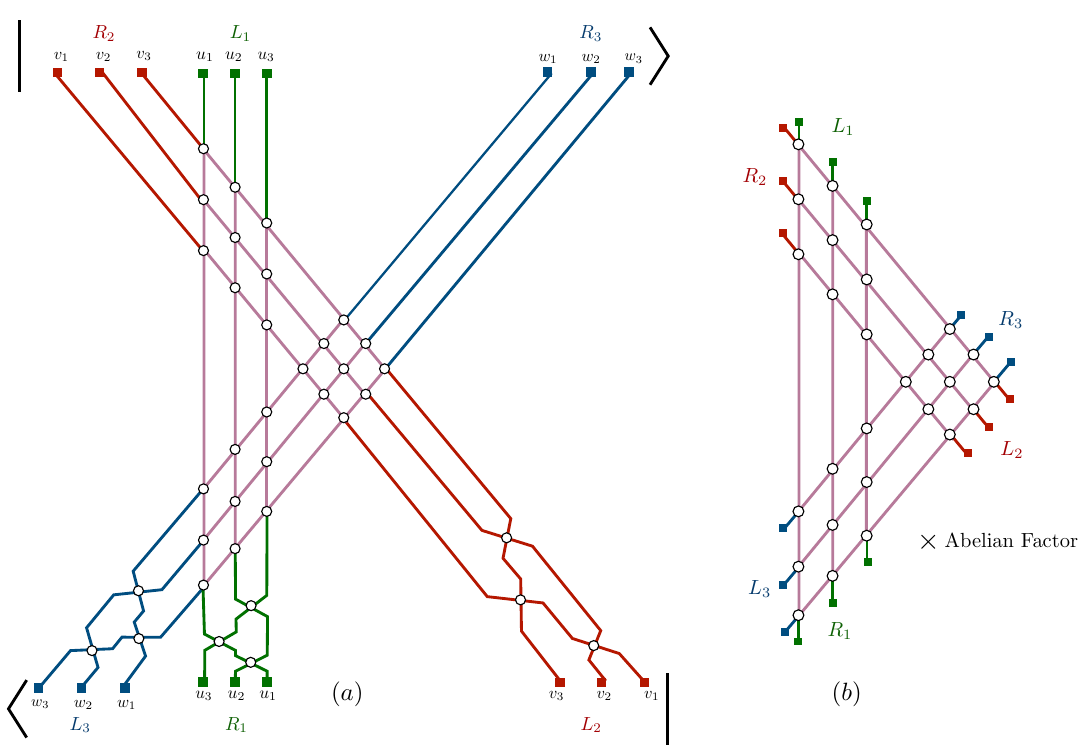
, illustrated here in the case Z , describe Figure 1 . (a) The hexagon partition function Z J 3 , 3 , 3 1 ,J 2 ,J 3 the scattering of three sets of fermions, labelled by their rapidities v , in the N = 4 i , u j , w k SYM spin-chain. Each set starts polarized in a fixed direction labeled by the spinors R 2 , L 1 , R 3 respectively. The particles then scatter in all possible pairings according to Beisert’s PSU(2 | 2) vertex. The final state is then projected into fermions of definite polarization spinors L . 2 , R 1 , L 3 In the gauge theory, the boundary conditions are set by the spacetime polarizations of spinning operators whose structure constants are governed by the hexagon partition function. Because the vertex is proportional to the identity when the incoming or outgoing particles are fermions with identical polarizations, the outer parts of the graph are trivial and result in a simple abelian factor. We represent these trivial scattering by the green red and blue colours. They can be factored out resulting in the equivalent representation (b). The interesting dynamics happens in the pink region in which particles from different sets